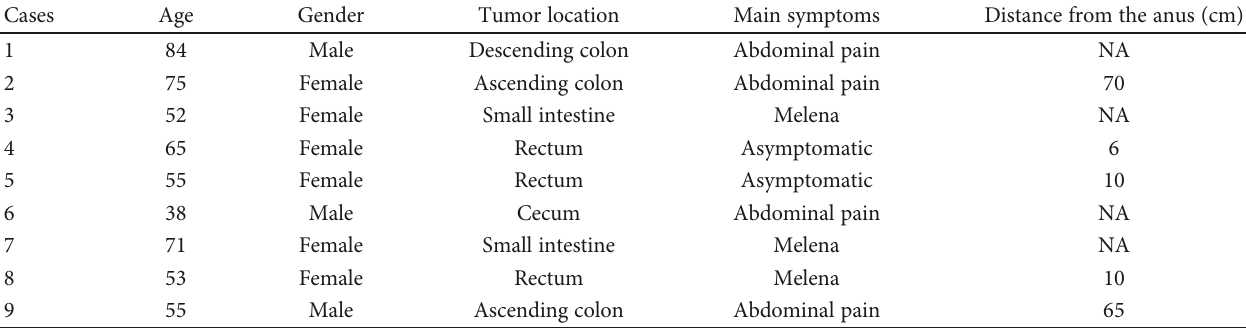
Table 1: Clinical data of patients with intestinal